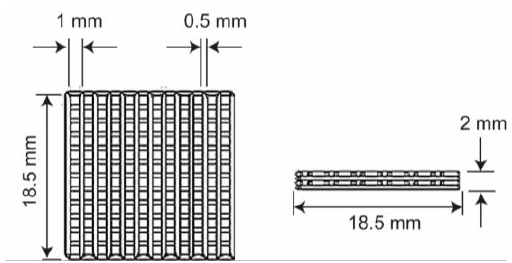
Figure 1. Polylactide acid (PLA) experimental sample dimensions in front and lateral views. Source: